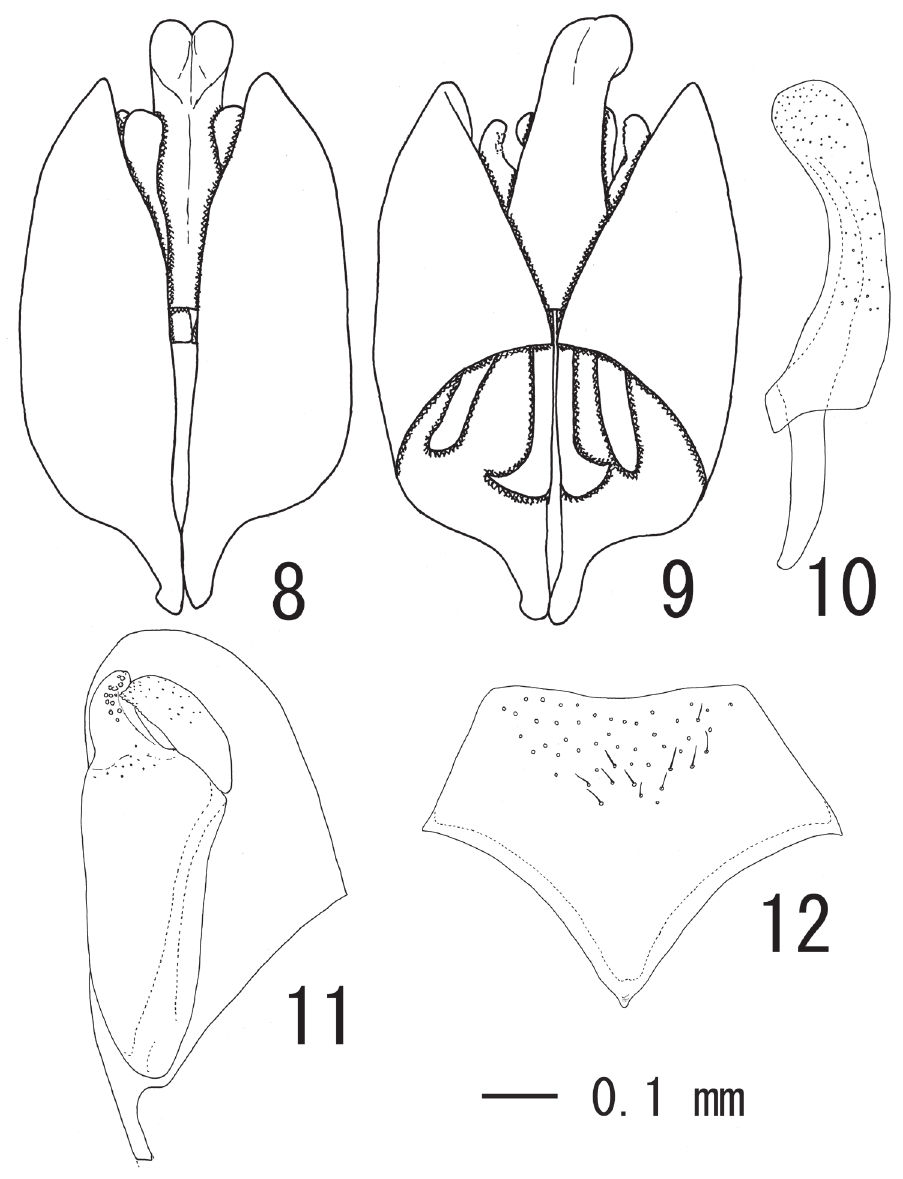
Figures 8–12. Male terminalia of C. sulawesiensis sp. n. (paratype). 8 Genital capsule ventral view 9 dit- to, dosal view 10 aedeagus, lateral view 11 left paramere, inner aspect 12 subgenital plate, ventral view. Male terminalia: subgenital plate pentagonal with median portion of apical margin weakly concave (Fig. 12); apex of paramere not projected beyond apex of aedeagus (Figs 8, 9), apical margin round (Fig. 11); aedeagus with basal apodeme about half as long as penis valve (Fig.